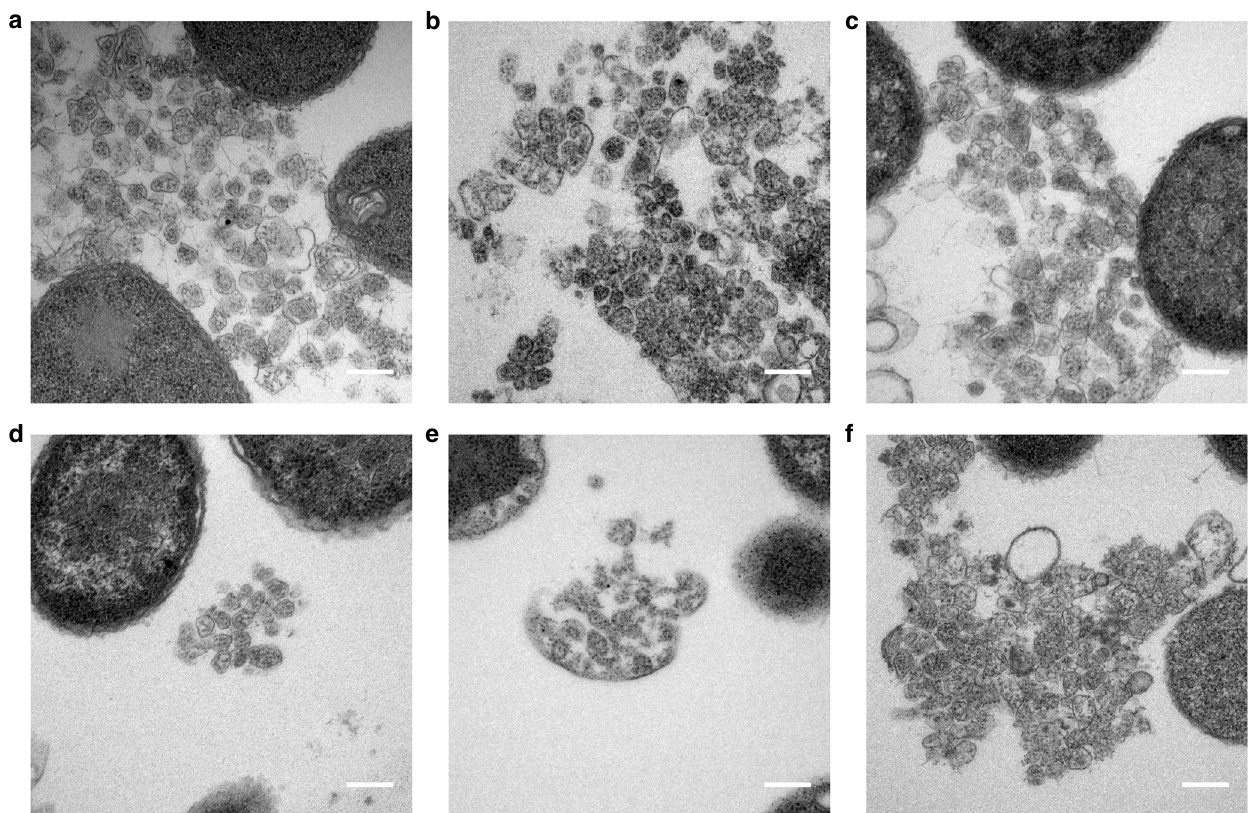
Fig. 6 TEM analysis of coiled-coil tagged circularly permuted BMCs. BMCs tagged with coiled-peptides from lysed E. coli BL21 * (DE3) cells expressing the following modi fi ed PduA proteins. a CC-Di-A-PduA P -U. b CC-Di-B-PduA P -U. c C-PduA P -U. d CC-Di-A-Citrine-PduA P -U. e CC-Di-B-Citrine-PduA P -U. f C- Citrine-PduA P -U. Scale bars show 0.2 µ